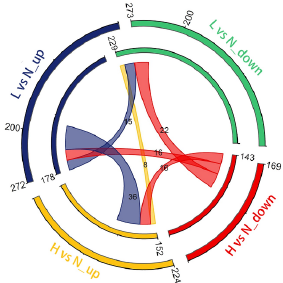
Figure 3. Relationship of upregulated or downregulated DETs. The outer and inner circles represent the DETs and the annotated genes of the DETs, respectively. The colored bands in the middle rep-